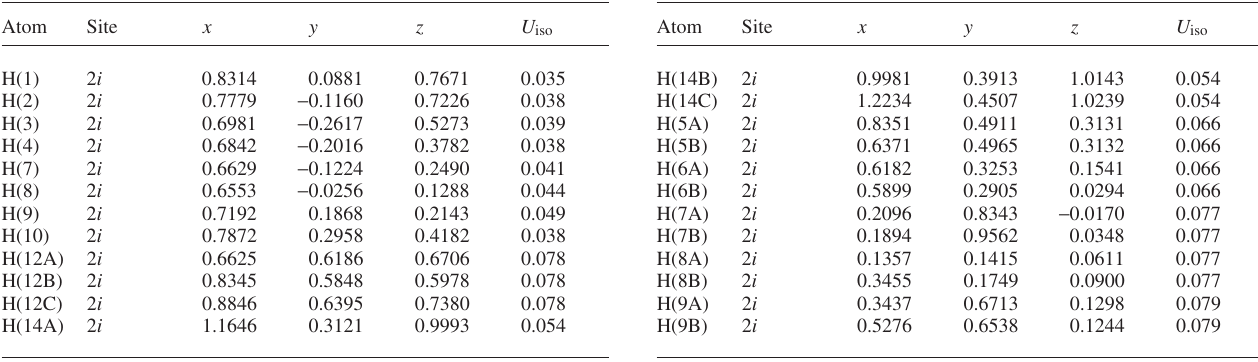
Table 2. Atomic coordinates and displacement parameters (in Å 2 )